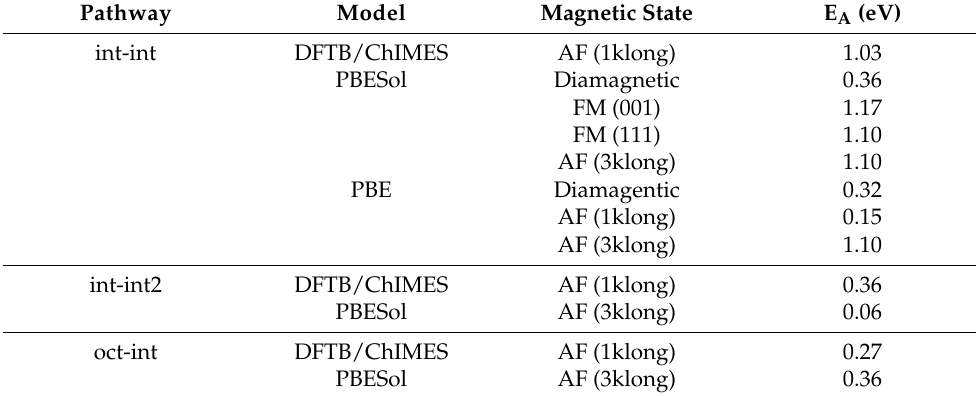
Table 4. Estimated activation energies for hydrogen diffusion hops from spin polarization calculations, only, where both GGA + U and SOC have been omitted. All calculations were performed on the experimental cubic lattice, excluding the PBE AF (1klong) results, where the tetragonally distorted cell was used and the hydrogen was moved in the direction of one of the shorter lattice vectors. Pathway Model Magnetic State E A (eV) int-int